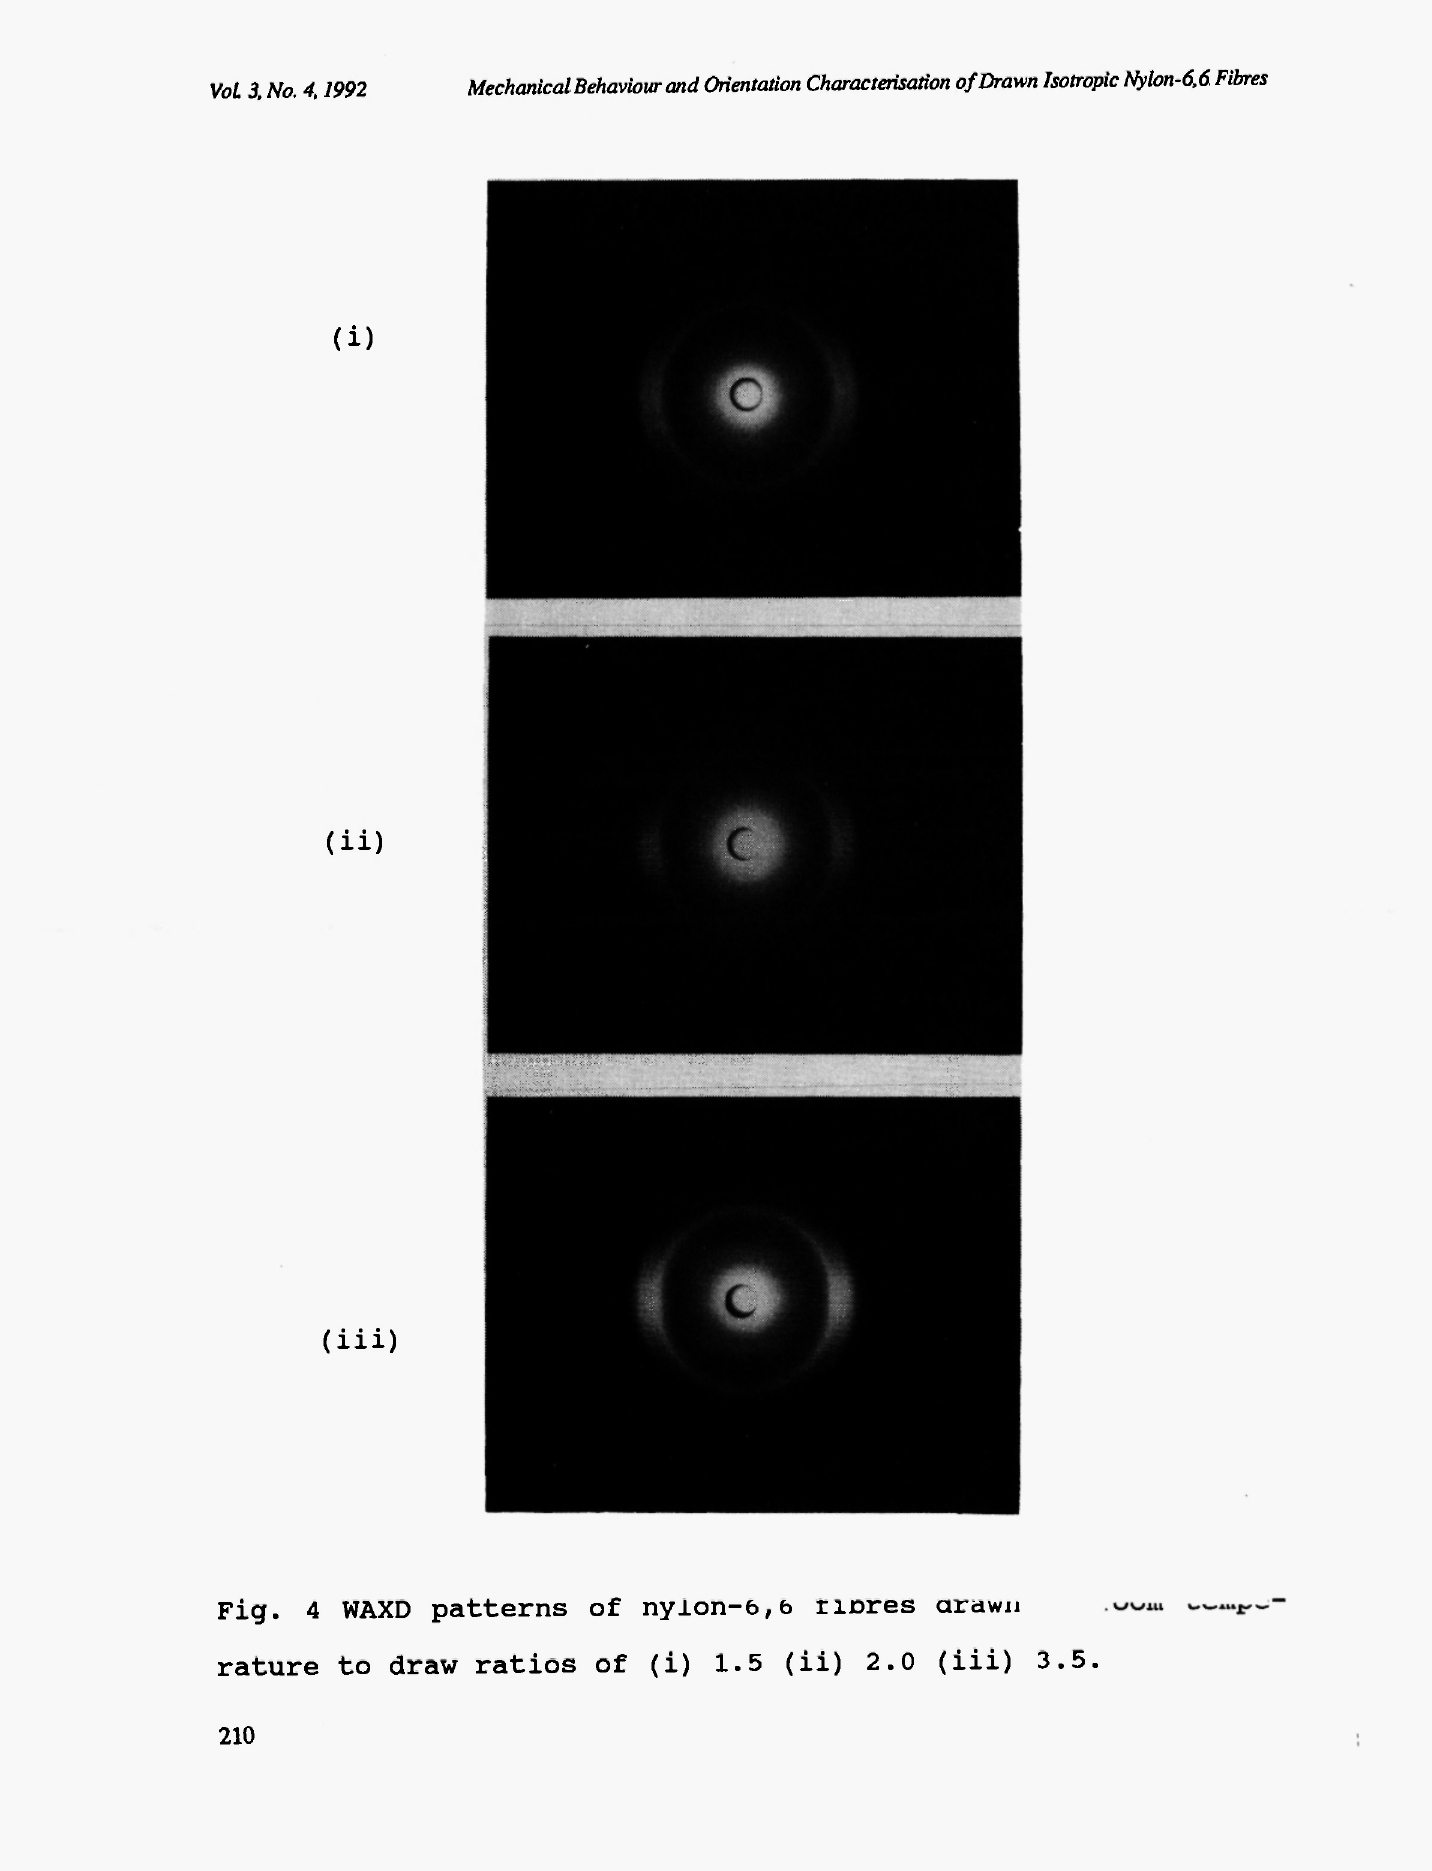
Fig. 4 WAXD patterns of ny±on-6,b rlores drawn rature to draw ratios of